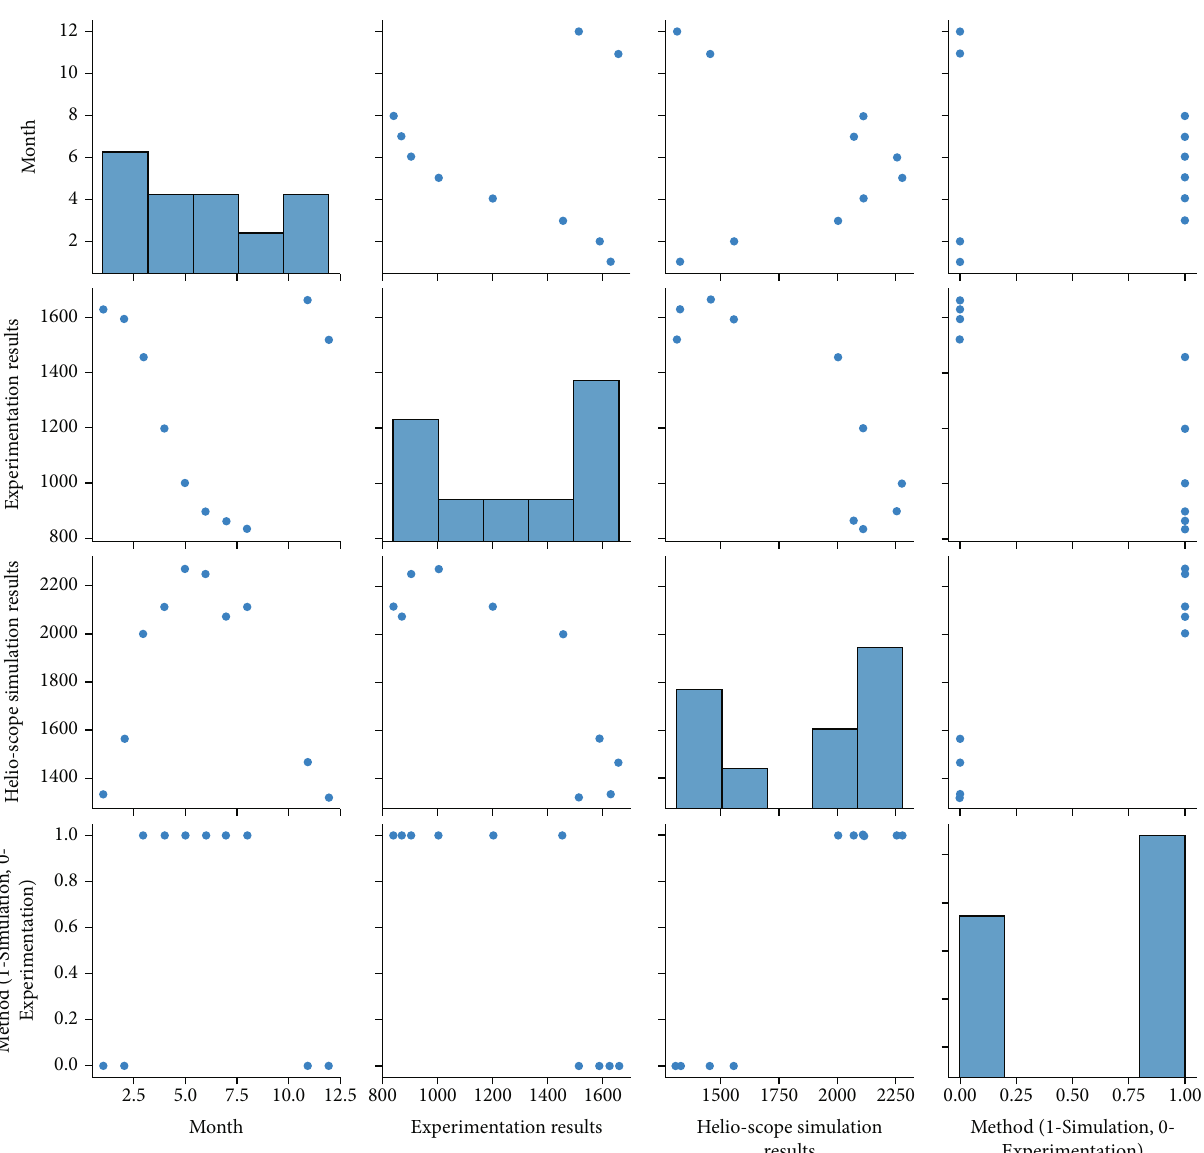
Figure 10: Pair plot of monoperk module data sets in grid-connected formation for correlation between each independent and dependent